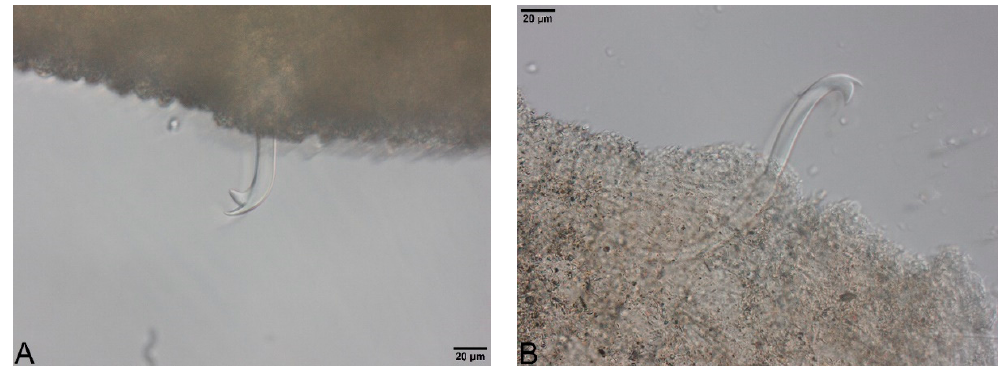
Figure 7. ( A ): Posterior ventral chaeta of Spirosperma ferox . ( B ): Posterior ventral chaeta of